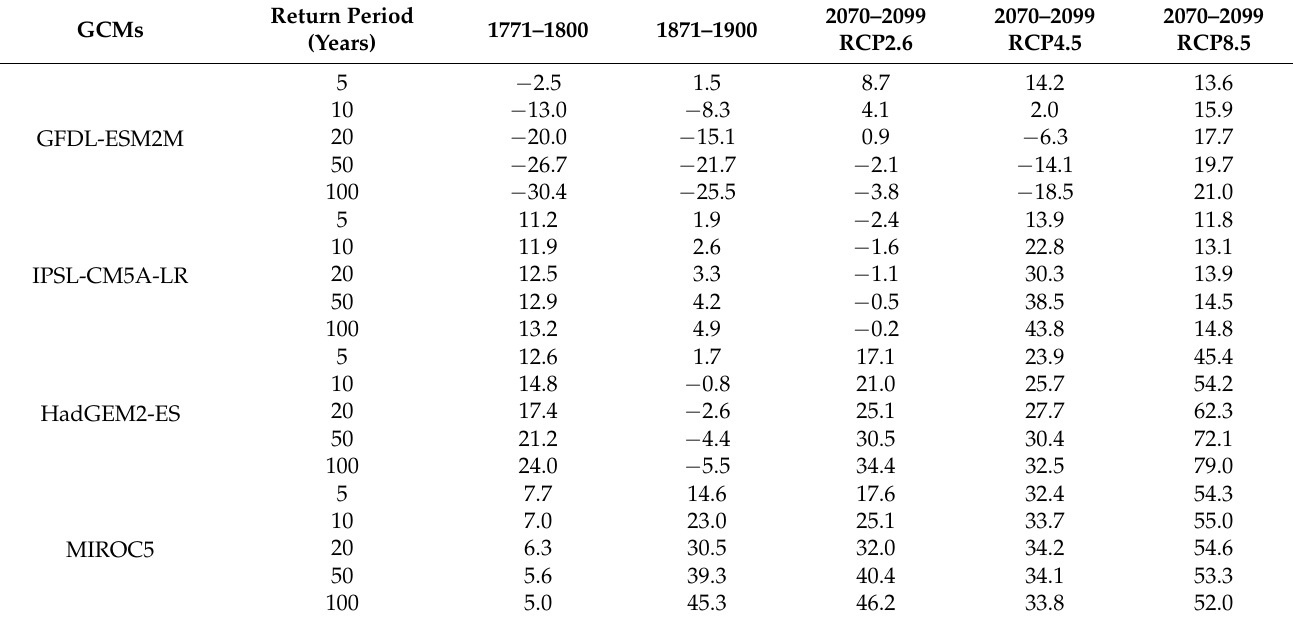
Table 3. Percentage changes (%) in extreme flood events with different return intervals for each of the four GCMs during all time periods relative to reference